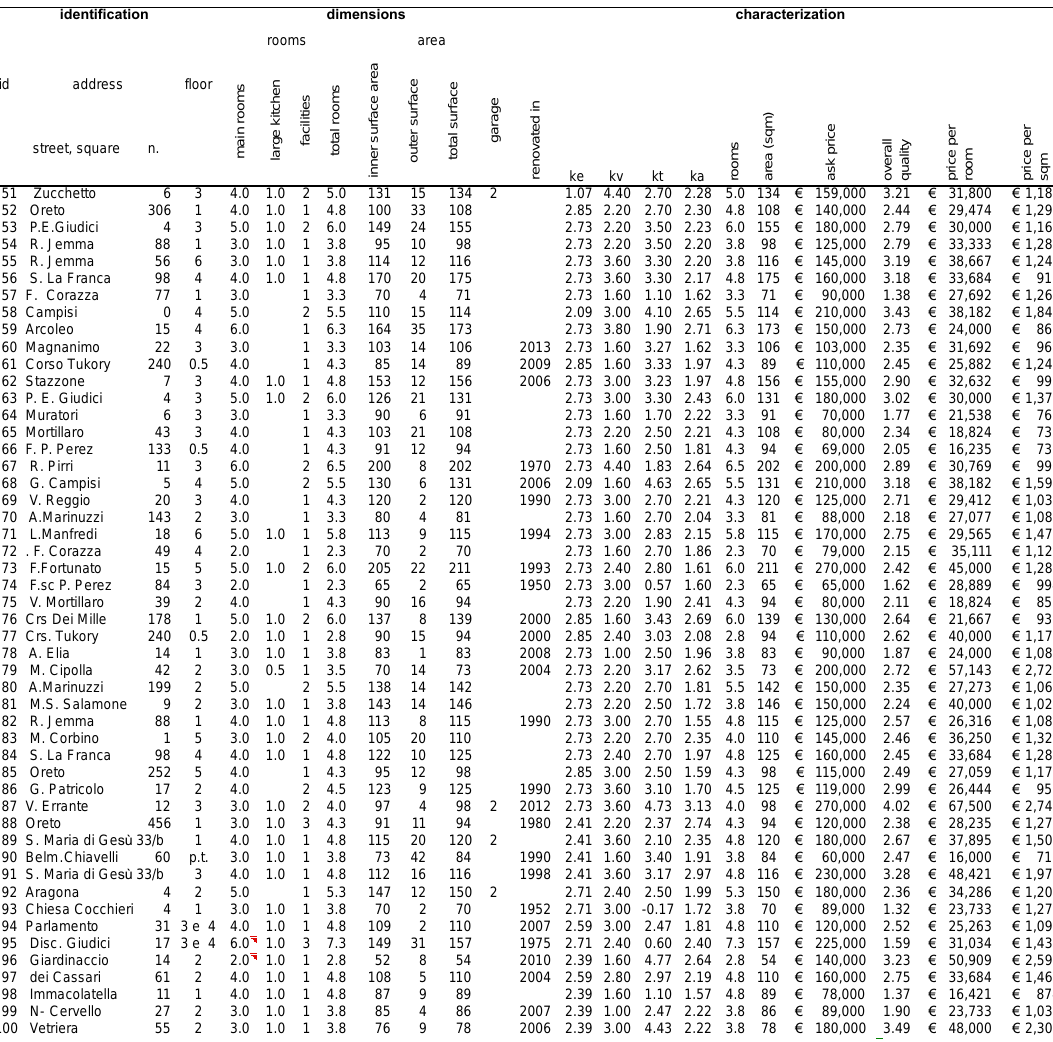
Figure 3. Portion of the database (from 51 to 100 items; the others items are omitted).